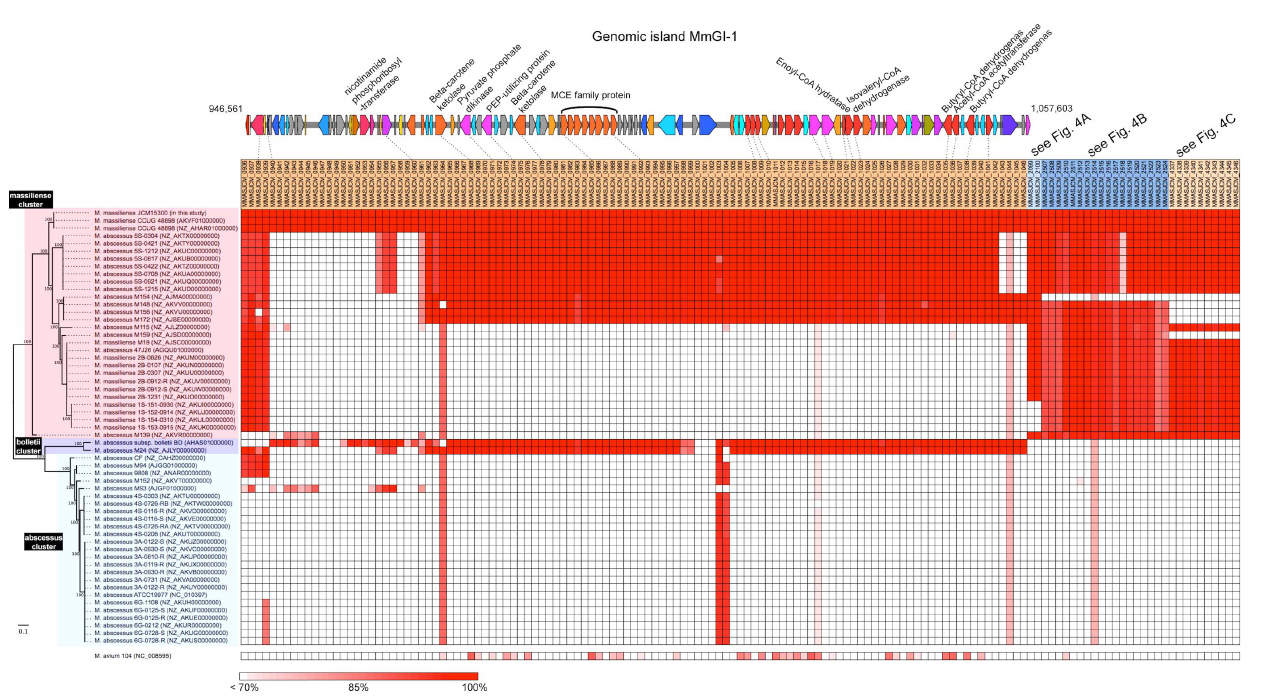
Fig. 2. Schematic representation of genomic island MmGI-1 and heatmap of MmGI-1, anaerobic respiration genes and mycolic acid synthase- related gene loci among 56 M. abscessus group strains. Phylogenetic tree based on 203,267 core genome SNPs in the whole-genome-sequenced M. abscessus group by the maximum-likelihood method with 1,000-fold bootstrapping. The scale indicates that a branch with a length of 0.1 is 10 times as long as one that would show a 1% difference between the nucleotide sequences at the beginning and end of the branch. The number at each branch node represents the bootstrapping value. The ORFs of M. massiliense strain JCM 15300 were aligned against the genomic sequences of 56 other M. abscessus group strains and M. avium 104 using TBLASTN (E-value cutoff, 1.00E-10; identity cutoff, 70%). A heatmap was constructed from amino acid